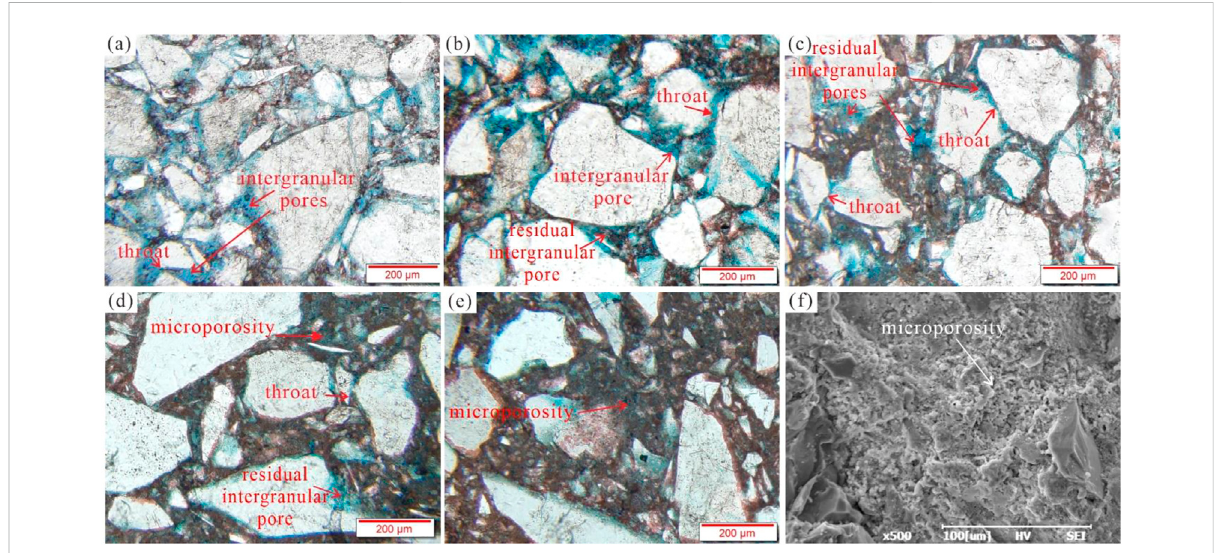
Typical thin section and scanning electron microscope (SEM) images of the samples with different cement content but with approximately the same porosity. Image (A) : cement content is 10 wt%, the structure is supported by the particles and the pores are dominated by intergranular pores. Image (B) : cement content is 15 wt%, the structure is supported by the particles and the pore system consists of intergranular pores and residual intergranular pores. Image (C) : cement content is 20 wt%, the structure is supported by the particles and the pore system mainly includes intergranular pores and residual intergranular pores. Image (D) : cement content is 25 wt%, the structure is supported by the cement and the pore system consists of residual intergranular pores and micropores. Image (E) : cement content is 30 wt%, the structure is supported by the cement. Image (F) : SEM image showing the development of